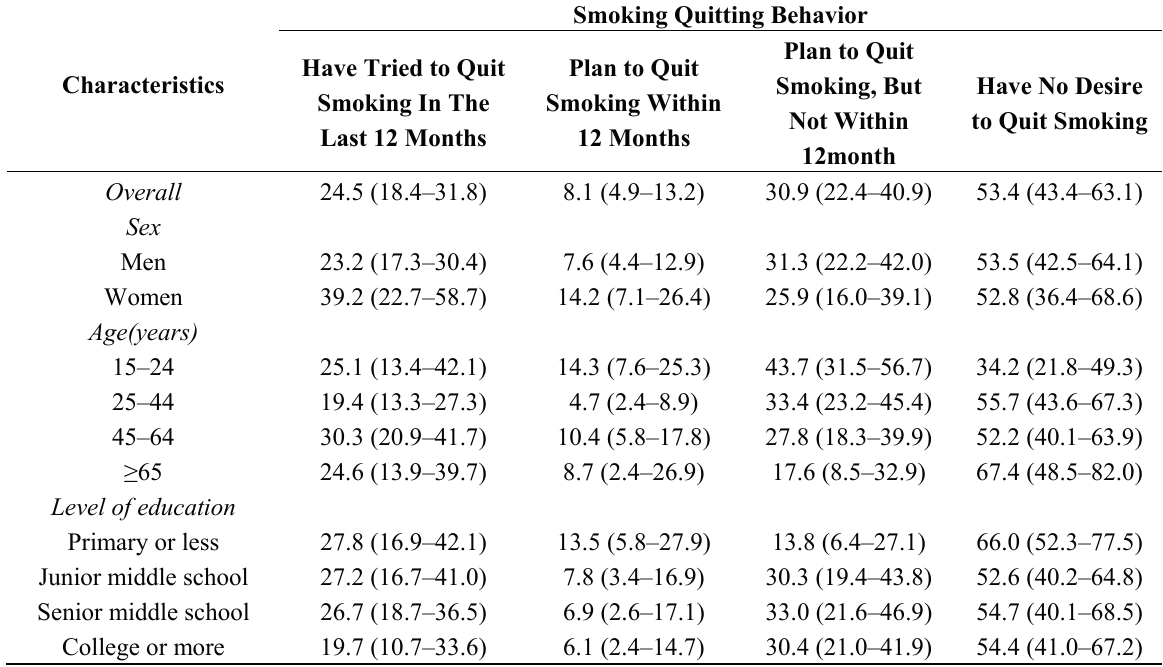
Table 3. Prevalence of smoking cessation among current smokers by sex, age group and level of educations in the last 12 months, weighted prevalence